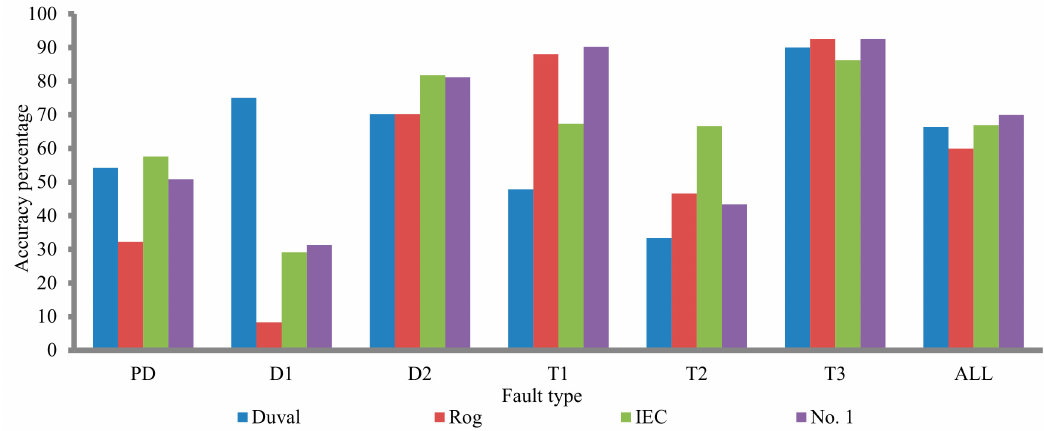
Figure 6. Comparison between the proposed technique no. 1 and its component method.